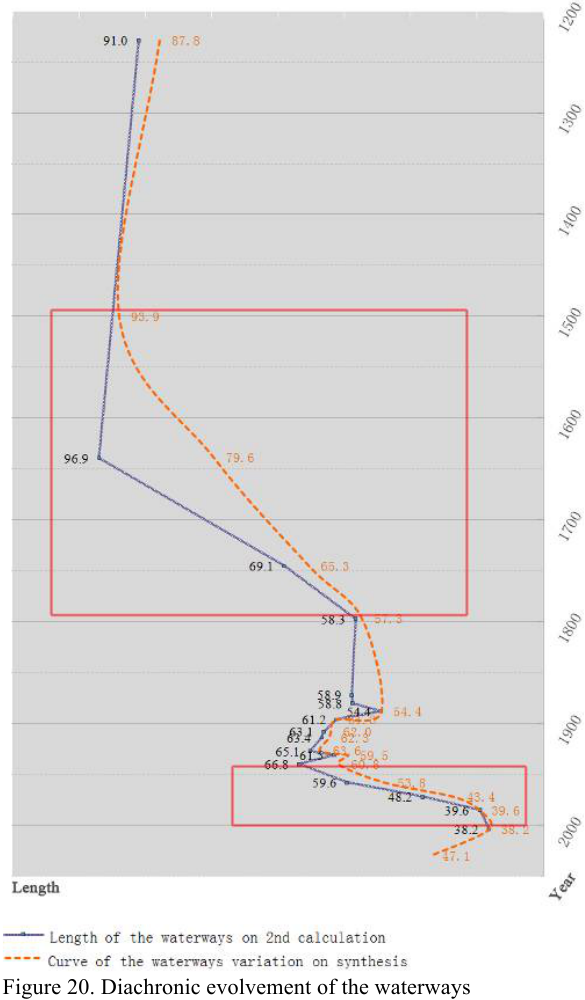
Figure 20. Diachronic evolvement of the